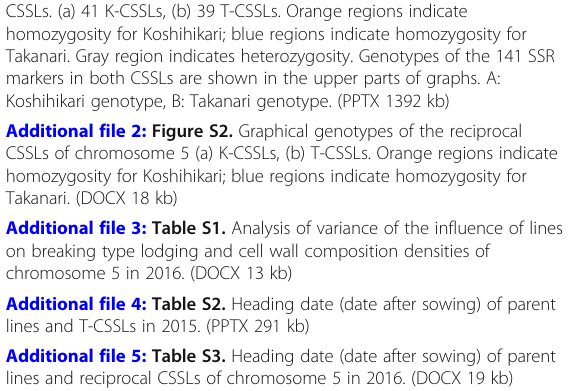
Additional file 1: Figure S1. Graphical genotypes of the reciprocal CSSLs. (a) 41 K-CSSLs, (b) 39 T-CSSLs. Orange regions indicate homozygosity for Koshihikari; blue regions indicate homozygosity for Takanari. Gray region indicates heterozygosity. Genotypes of the 141 SSR markers in both CSSLs are shown in the upper parts of graphs. A: Koshihikari genotype, B: Takanari genotype. (PPTX 1392 kb) Additional file 2: Figure S2. Graphical genotypes of the reciprocal CSSLs of chromosome 5 (a) K-CSSLs, (b) T-CSSLs. Orange regions indicate homozygosity for Koshihikari; blue regions indicate homozygosity for Takanari. (DOCX 18 kb) Additional file 3: Table S1. Analysis of variance of the influence of lines on breaking type lodging and cell wall composition densities